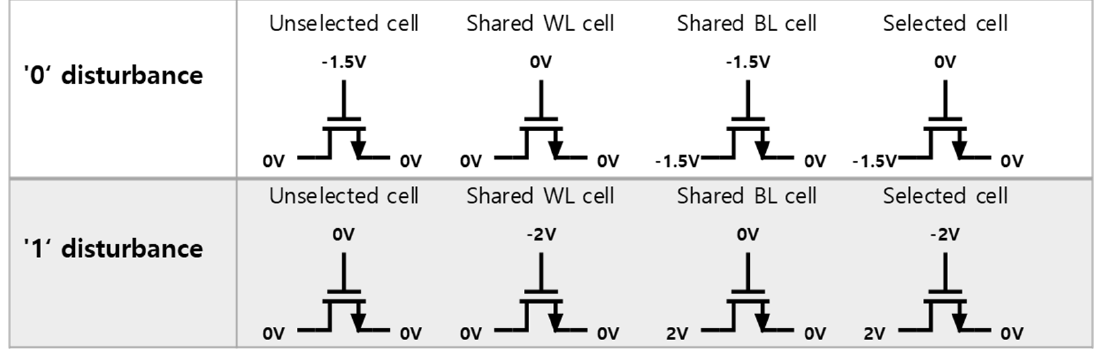
Figure 4. Timing diagram of first simulation for ( a ) selected WL and BL and ( b ) unselected WL and BL.